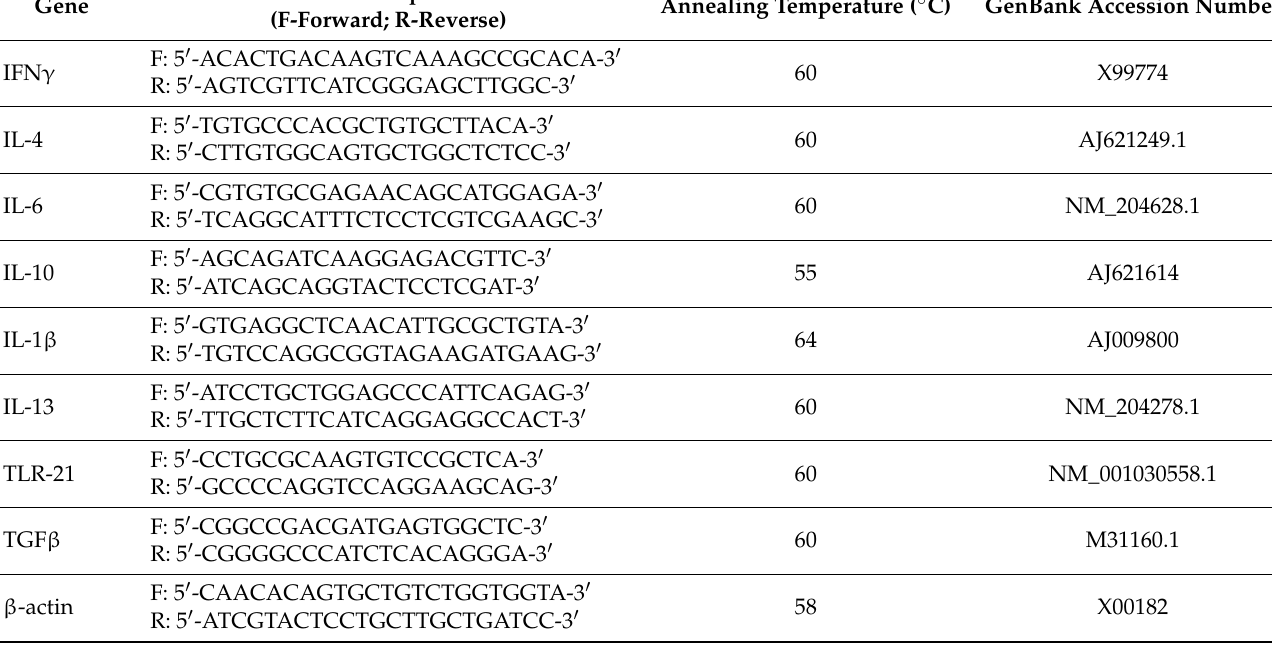
Table 1. Primer sequences used in real-time PCR